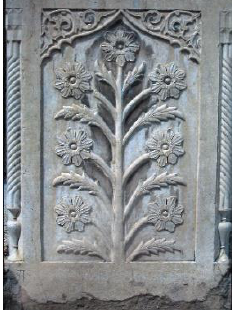
Figure 5. A bas-relief of a flower growing from the lower side of the frame, Vakil Mosque, Shiraz, Sarvestani, 2005